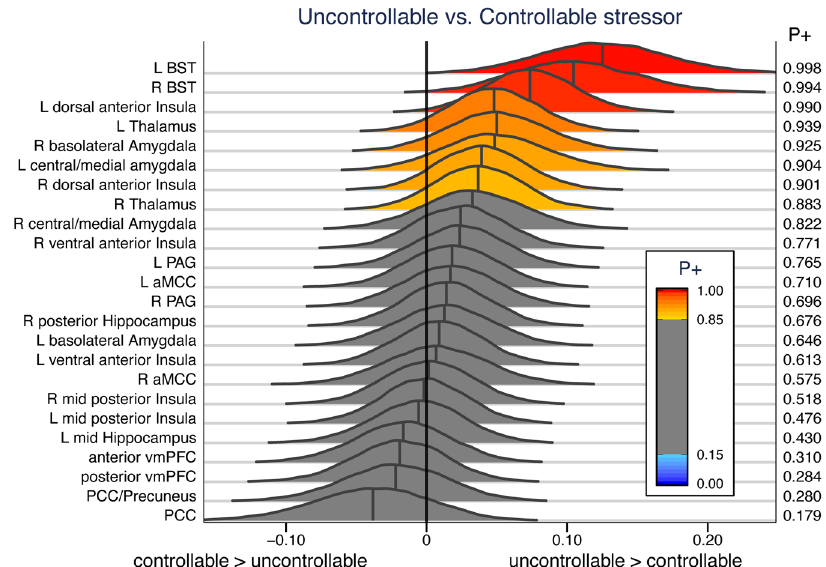
Fig. 3 Posterior distributions of the effect of group membership. Three regions of interest exhibited very strong evidence of stronger responses for uncontrolled participants: left/right BST and anterior dorsal insula. P + indicates the probability that uncontrollable > controllable. aMCC